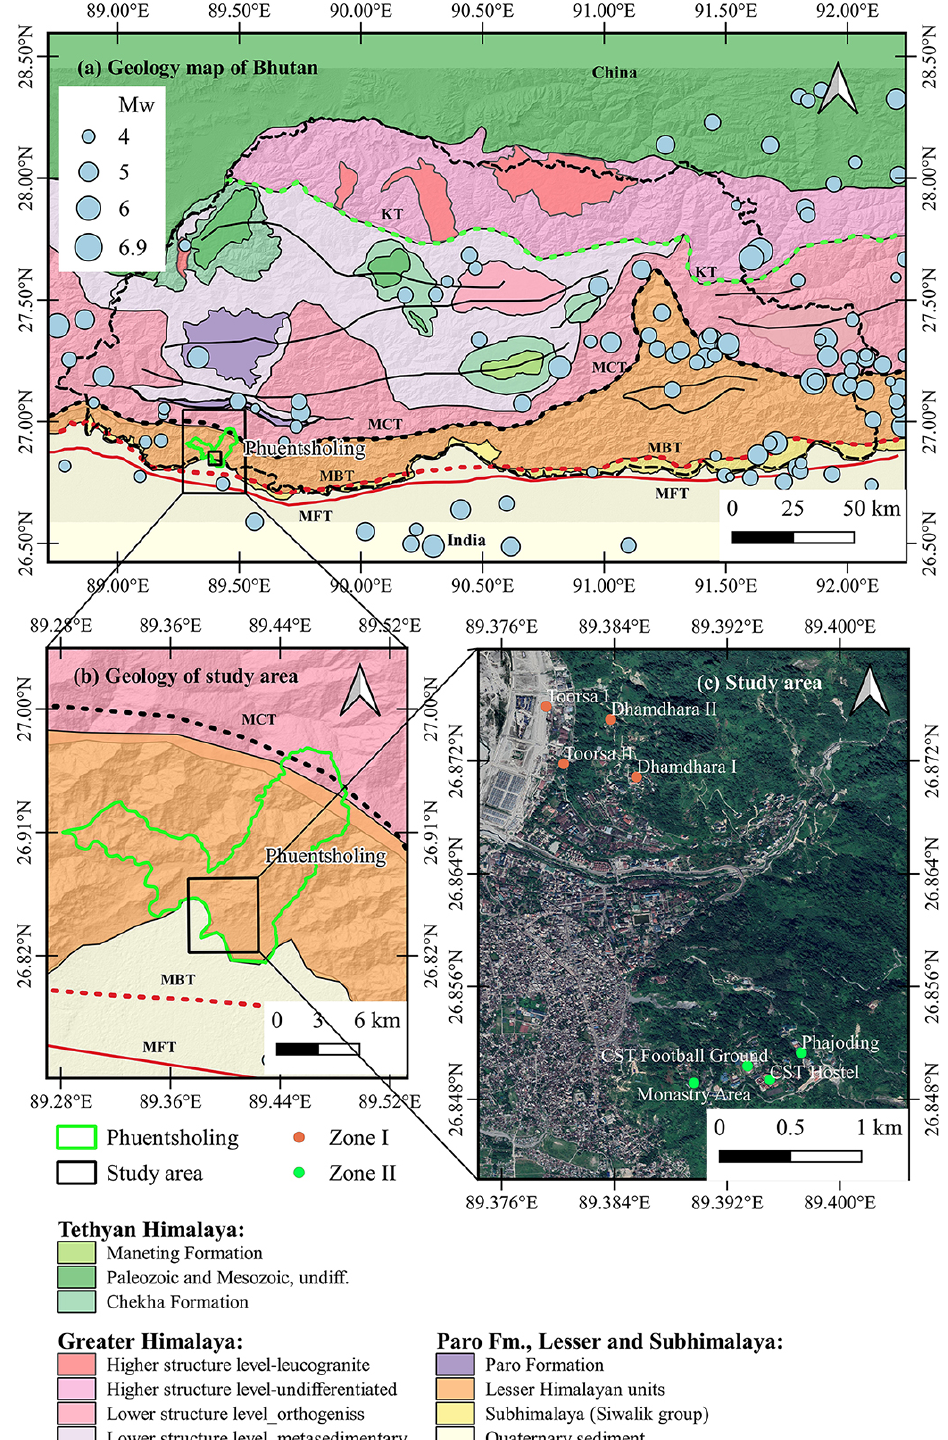
Figure 1. Geology and seismicity and the study area: (a) geological map of Bhutan reproduced from McQuarrie et al. (2013) and seismicity, (b) location of Phuentsholing and geology of the area, and (c) study area showing surveyed site using MASW (modified from © Google Earth Pro